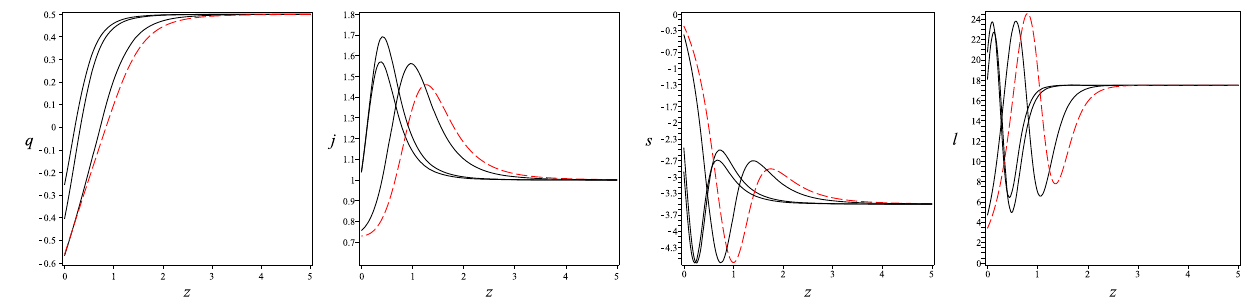
Fig. 3 The plot of cosmographic parameters as a function of redshift for best fitted parameters, α = 0 . 1 and c = 0 . 112 and different initial conditions. The red dash line shows the trajectory for best fitted parameters and best fitted initial conditions